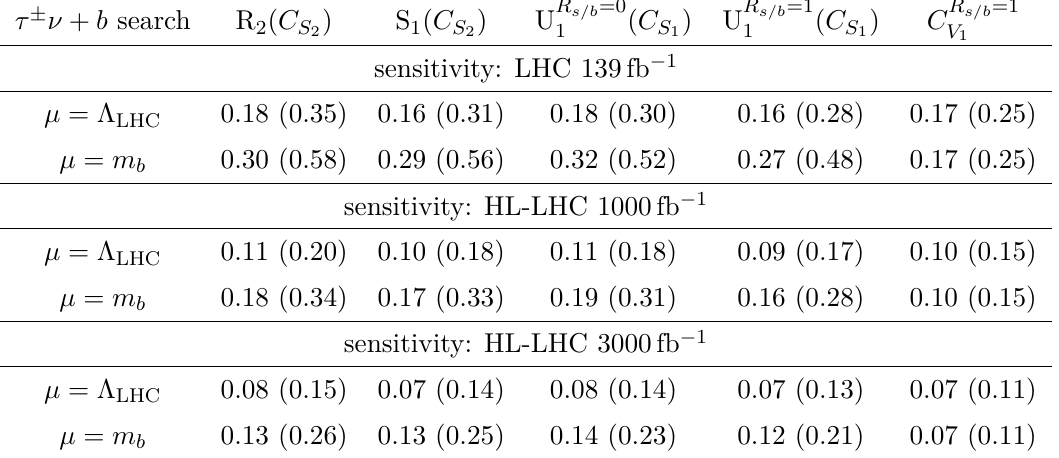
Table 8 . Same as table 7 but for cut b (the τ ± ν + b